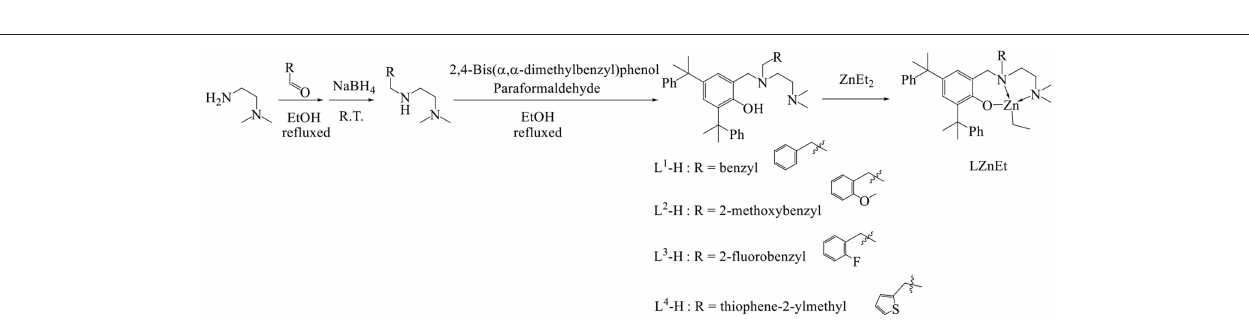
FIGURE 1 | Zn complexes bearing tridentate ( A ; Williams et al., 2003), ( E ; Hu et al., 2018), and tetradentate ( B–D ; Yang et al., 2015) aminophenolate ligands.